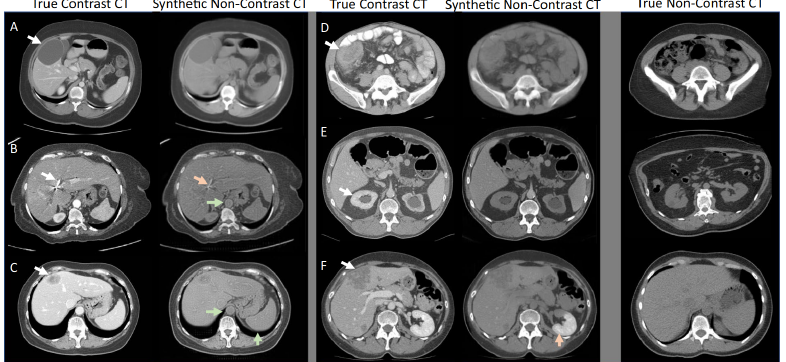
Figure 3. Adapted from Sandfort et al. [12], the study presented examples of true contrast CT scans and synthetic non-contrast CT scans generated using a CycleGAN. The left columns show the true contrast CT scans, while the right columns present the synthetic non-contrast CT scans. It is observed that the synthetic non-contrast images generated with CycleGAN appeared convincing, even in the presence of significant abnormalities in the contrast CT scans. The last column on the right displays unrelated examples of non-contrast images. The letters A to F in this figure represent various abnormalities/pathologies, and the arrows indicate their corresponding synthetic non-contrast CT images. However, they are not essential for understanding the main purpose of the figure, which is to demonstrate the generator’s ability to produce realistic